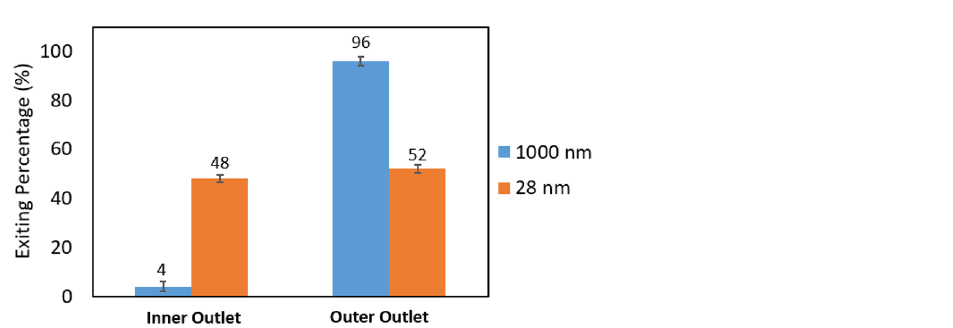
Figure 8. Results of 1000 nm polystyrene particles location imaging test (test B2). (a) Image taken by fluorescent microscope (the walls of the channel are marked by the white lines), (b) the light intensity across the width of the channel based on the image above the graph.